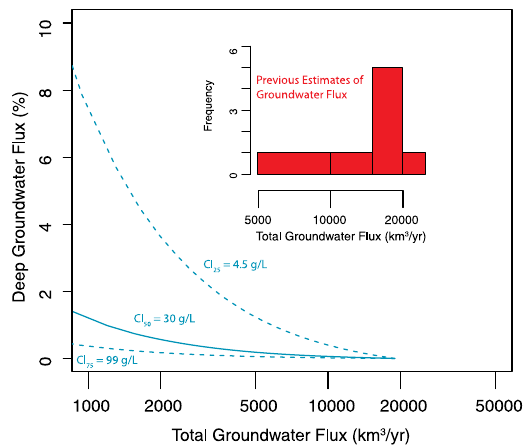
Fig. 2 Global groundwater fl uxes estimated using the Cl concentration of 18 mg/L for shallow groundwaters and the 25th (4.5g/L), 50th (30 g/L) and 75th (99 g/L) percentiles for groundwater Cl concentrations beneath 500 m, assuming all Cl in the world ’ s streams is from groundwater. At a contribution of less than 2%, the contributions of deep groundwater would result in a total groundwater fl ux less than previous estimates 24 – 29 , indicating that deep groundwater does not make a substantial contribution to fl uxes of water globally on human